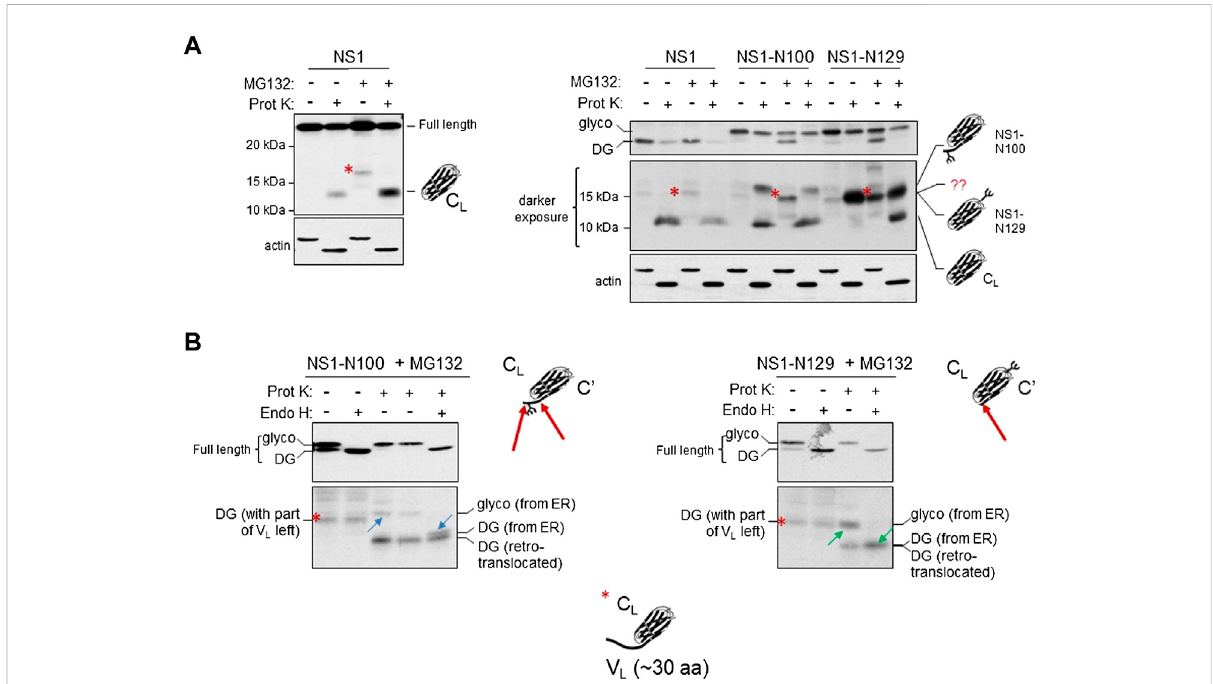
FIGURE 5 The retrotranslocated and deglycosylated C L domain maintains structure as indicated by resistance to Proteinase K digestion. (A) Cells were transfected with parental NS1, NS1-N100 or NS1-N129 and incubated with (+) or without (-) MG132 for 3.5 h prior to lysis. Lysates were treated with (+) or without (-) Proteinase K as described in Materials and Methods and analyzed by western blotting with anti- κ antisera. On the left, analysis of parental NS1isshown alone,and ontherighttogetherwith thetwoglycosylatedconstructs.Migrationoffull-lengthNS1isshown inthetop on right, whereas a longer exposure of the fragments generated is below. A MG132-generated fragment present with all three constructs is indicated witharedasterisk.Thededucedidentityofthevariousfragmentsbasedondatain (B) areportrayedwithcartoonschematics. (B) Cellsexpressingthe indicated glycosylated constructs wereincubatedwith MG132 prior to lysis. Lysates were treated either with (+)or without (-) Proteinase K, and then splittoallow subsequentdigestionwithEndoH(+)foronehalfandleftundigested (-)fortheotherhalfasacontrol.Thealteredmobilityoffragment pairs that were glycosylated and cleaved by Endo H are indicated with blue arrows for NS1-N100 or green arrows for NS1-N129. Schematic representations of Proteinase K cleavage of both proteins are shown with a red arrow on the schematic. Fragment identities and their source are